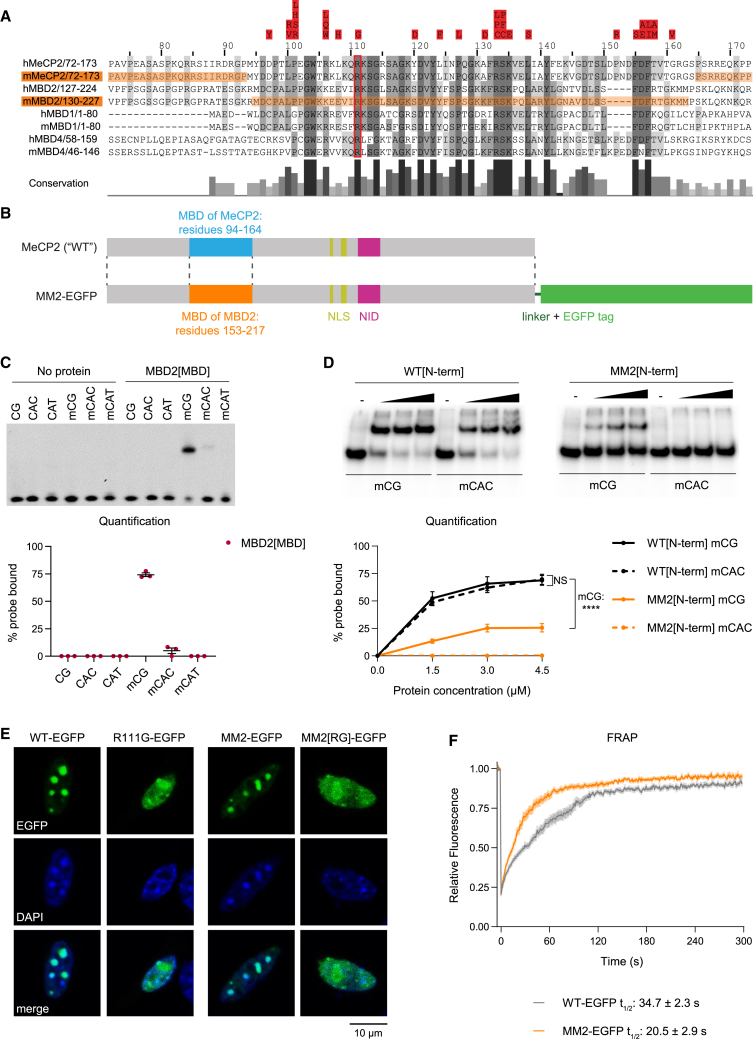
Chimeric protein MM2 has the DNA binding properties of MBD2 in the context of MeCP2(A) Alignment of human (h) and mouse (m) MeCP2, MBD2, MBD1, and MBD4, shaded by percentage identity, with conservation below. Annotations: RTT-causing missense mutations within the MBD (red, above); conserved arginine at position 111 in MeCP2 (boxed in red); sequences from mMeCP2 and mMBD2 used in MM2 (shaded in orange).(B) Schematic showing the design of the chimeric protein MM2, where the MBD of MBD2 (residues 153–217) was inserted into the MeCP2 protein sequence to replace the endogenous MBD (residues 94–164). MM2 was tagged at the C terminus with EGFP.(C) EMSA analysis of the MBD of human MBD2 (2 μM) binding to DNA probes containing a single unmethylated or methylated CG, CAC, or CAT site. Quantification is shown below (means ± SEMs).(D) EMSA analysis of N-terminal fragments (residues 1–205) of wild-type (WT) MeCP2 and MM2 using DNA probes containing a single mCG or mCAC site (protein concentrations 0–4.5 μM). Quantification is shown below (means ± SEMs). Binding affinity was compared using 2-way ANOVA: WT mCG versus mCAC, NS p = 0.613; mCG WT versus MM2, ∗∗∗∗p < 0.0001.(E) Representative images showing localization of EGFP-tagged MeCP2 (WT) and MM2 proteins to mCG-rich heterochromatic foci following transient overexpression in mouse fibroblasts. Mutation of the MBD (R111G and the equivalent mutation in MM2) abolished binding, resulting in diffuse localization. Scale bar, 10 μm.(F) FRAP analysis at heterochromatic foci. Total numbers of cells analyzed: WT-EGFP, n = 27; MM2-EGFP, n = 28 (3 independent transfections). Graph shows fluorescence relative to prebleach, means ± SEMs. Half-lives: WT-EGFP = 34.66 ± 2.32 s; MM2-EGFP = 20.46 ± 2.88 s (means ± SEMs). Half-lives were compared using a Mann-Whitney test: ∗∗∗∗p < 0.0001.